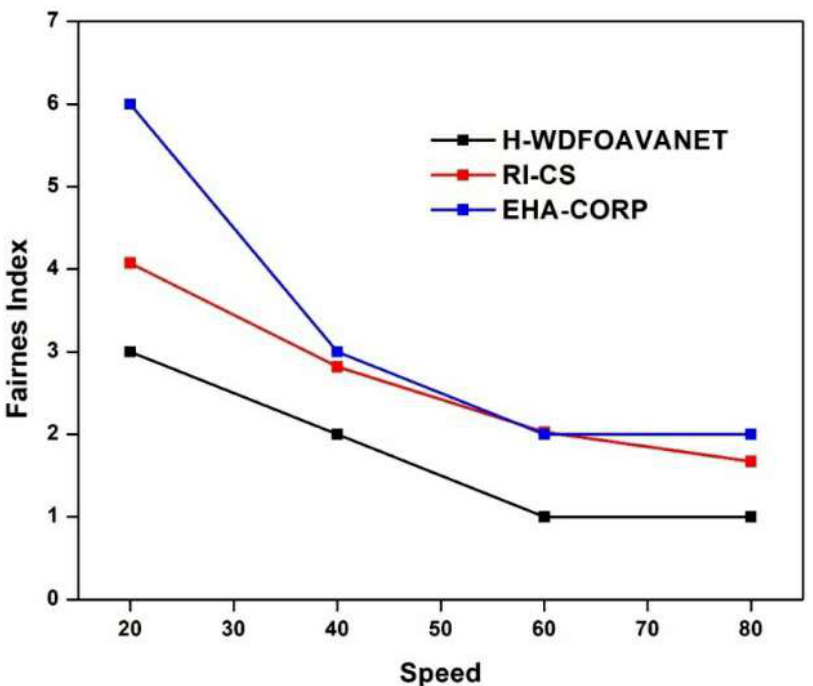
Figure 23. Plots of speed vs. throughput in the suggested approach and existing approaches.